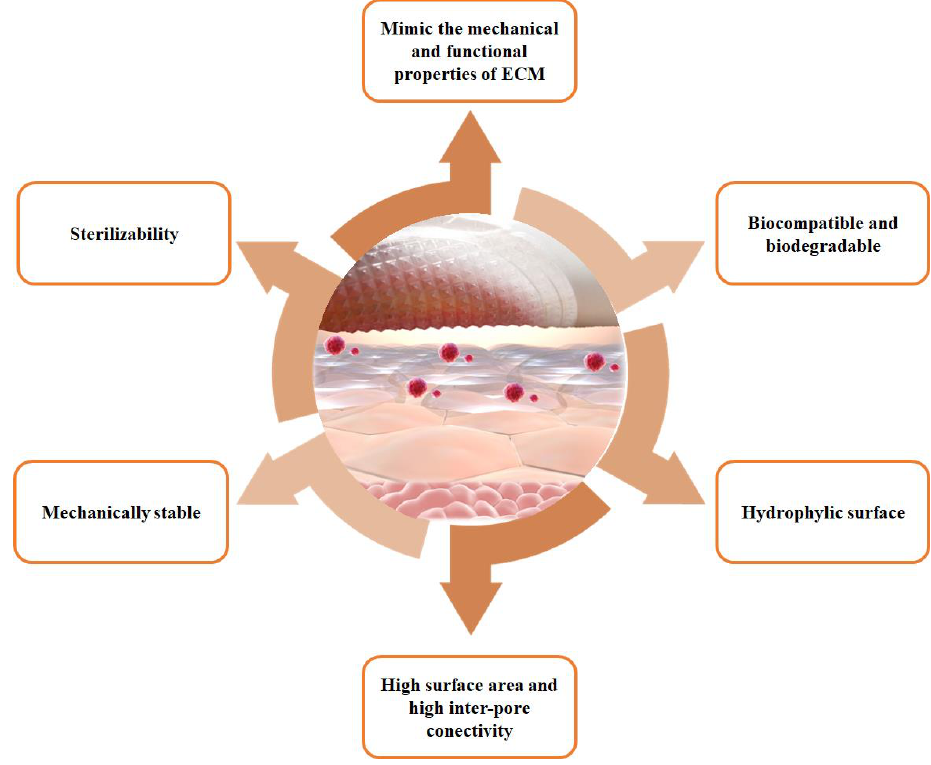
Figure 5. Main characteristics for tissue scaffold design.